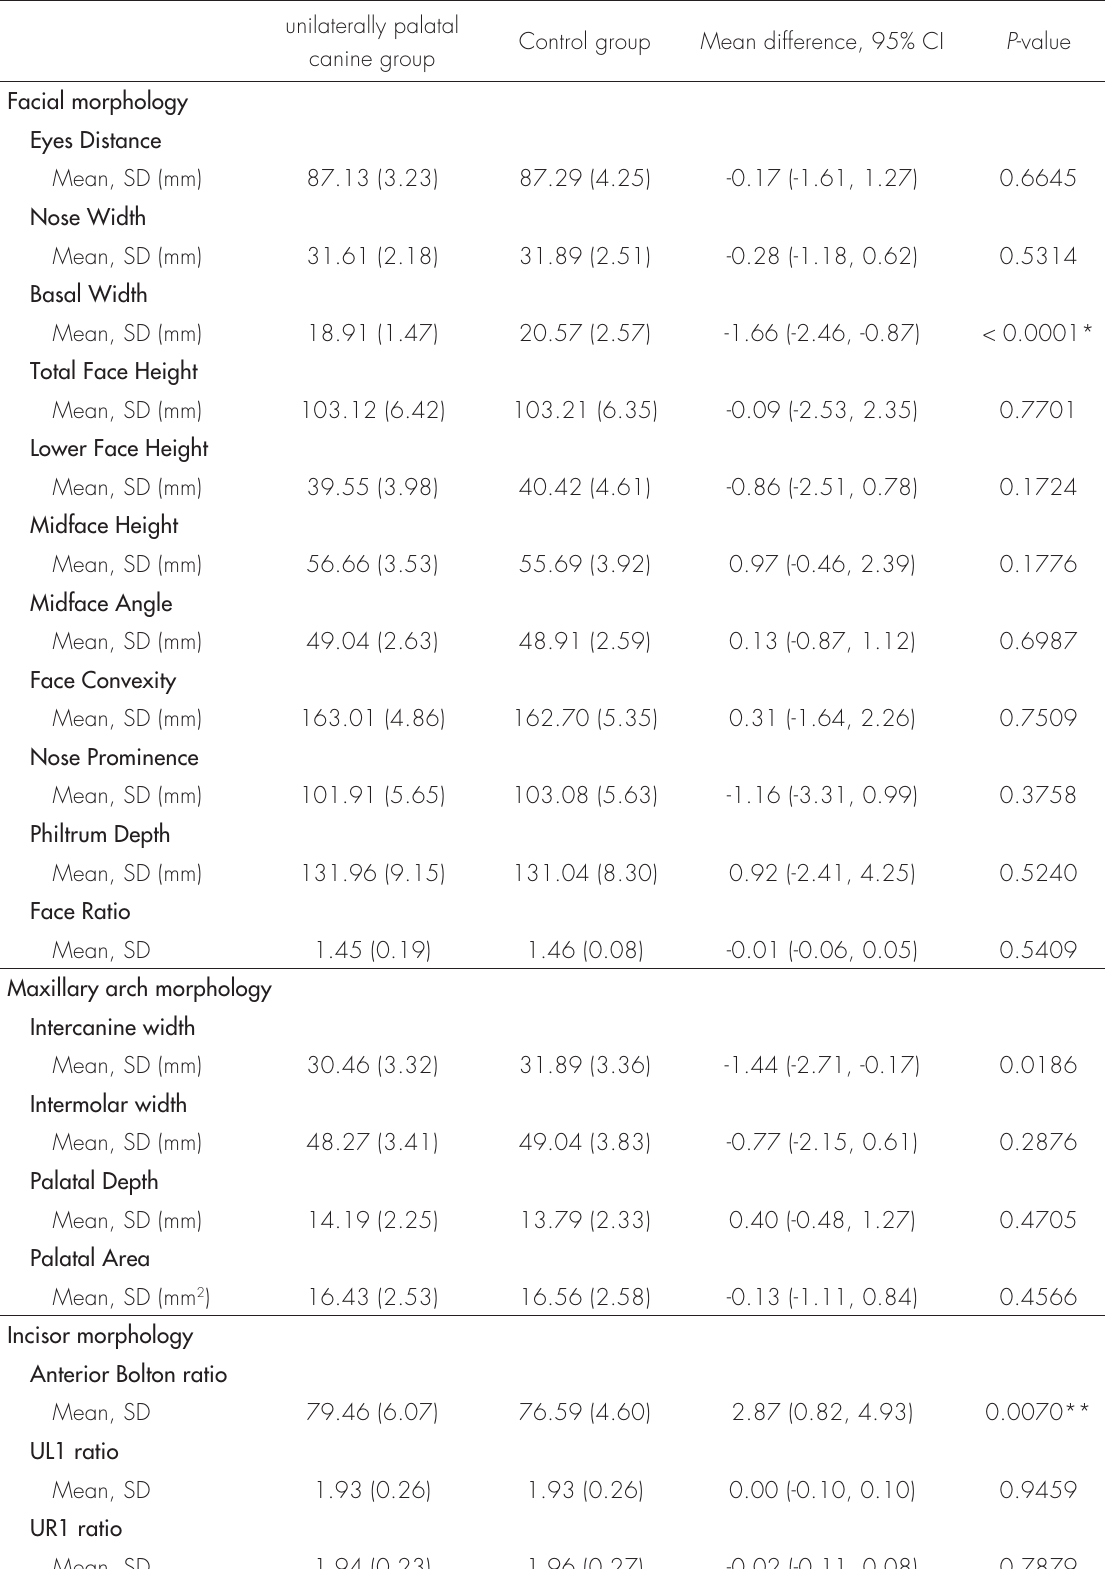
Table V. Facial soft-tissue, maxillary arch and incisor dimensions for the unilateral palatal canine and control groups. unilaterally